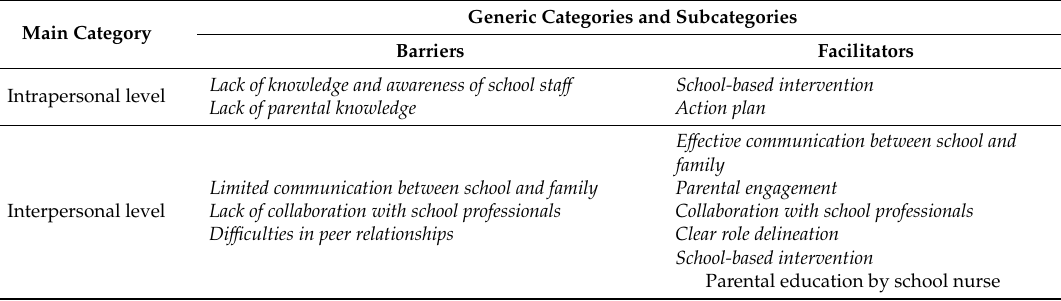
Table 1. Synthesis of the key